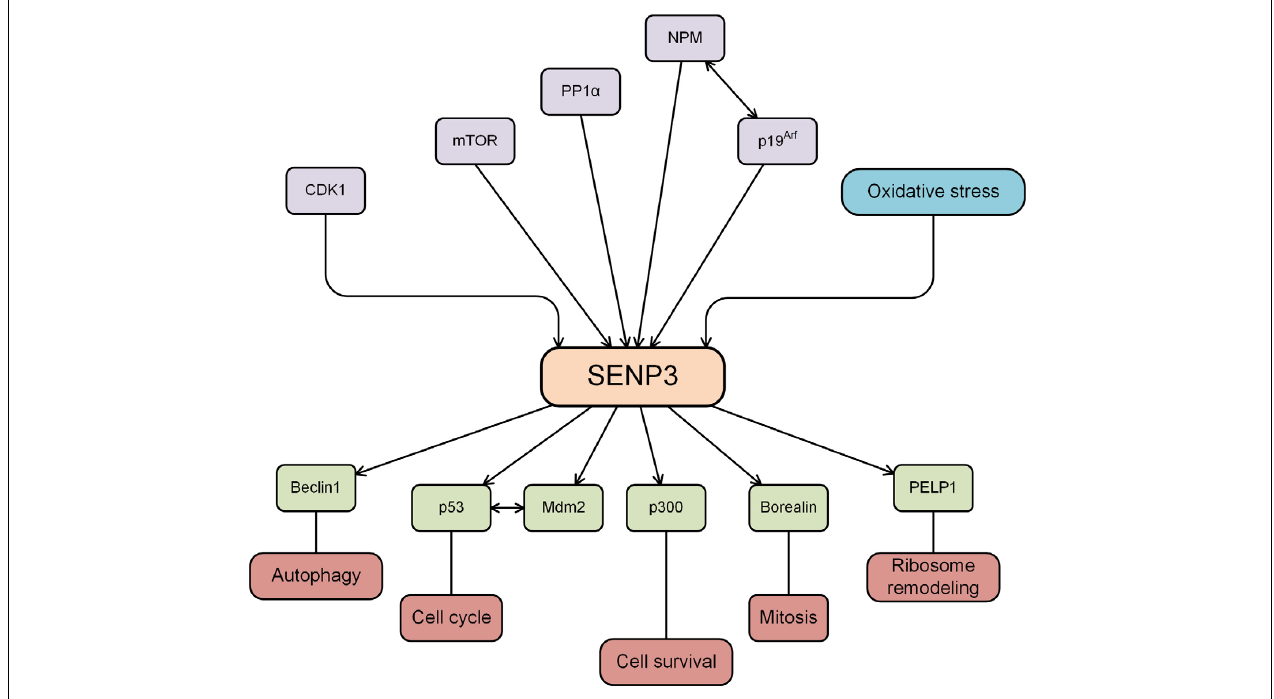
FIGURE 1 | SENP3 is regulated by several proteins, while SENP3 deSUMOylates substrates and plays an important role in various cellular activities.